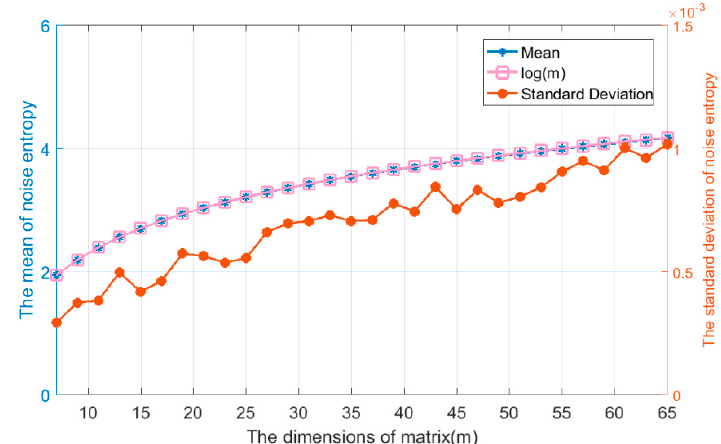
Figure 7. The relationship between the distribution characteristics and dimension of the trajectories matrix ( m ) under hypothesis H 0 ( L = 30, J = 4). The mean of the singular spectrum entropy is approximately equal to the log m curve, and the standard deviation of singular spectrum entropy is similar to zero.